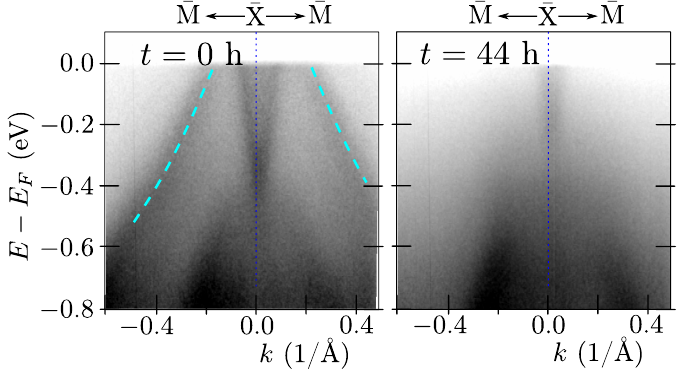
Figure 8. The ARPES results obtained around the ¯X point presenting the realized surface states. The panels present spectra collected at different time points following the sample cleaving. Cyan dashed lines highlight the surface state. The measurements have been realized with He-I ( h ν = 21.218 eV) radiation for the sample cleaved and measured at a temperature of 20 K. From a theoretical point of view, the most favorable type of termination can be pre- dicted by calculation of the binding energy within the DFT framework. To find this type of prediction, we calculated the binding energy ∆ E between the adjacent layers: ∆ E = E − E − E A+B A B , where E A+B , E A , and E B denote the energy of products (A + B) and individual reactants (A and B), respectively. In practice, E A + E B can be calculated when the last layer (B) is ∼ 10 Å above substrate (A) with respect to the investigated